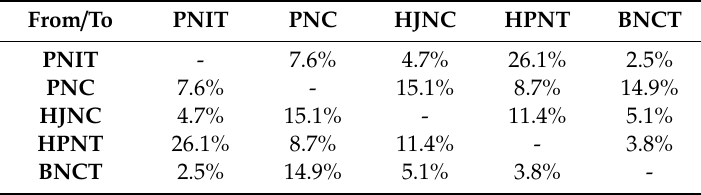
Table 2. Container movement rate between terminals [32].